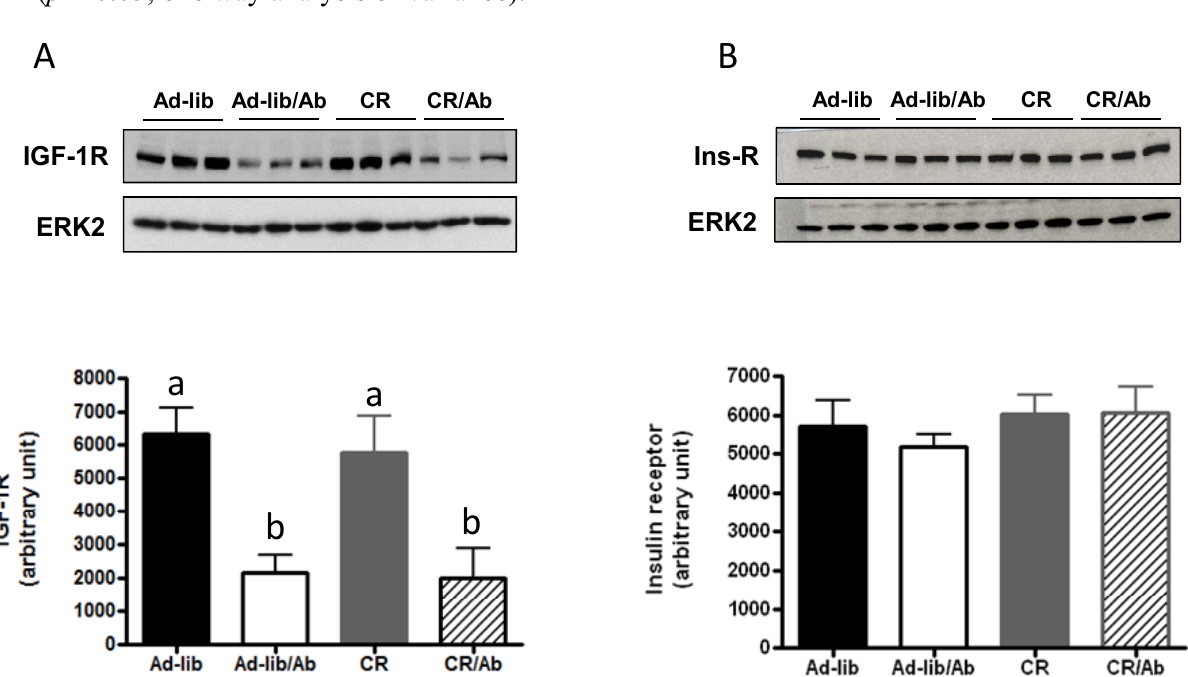
Figure 3. Effect of the intervention on IGF-1 and Insulin receptors expression in 22Rv1 xenografts. ( A ) IGF-1 receptor expression; ( B ) Insulin receptor expression. In ( A ) and ( B ), total ERK2 was used as a loading control. The Western blots are representative of one experiment ( n = 3 animals per group). The western blots were done on a total of 6 animals per group. Densitometric analysis is presented in the bar graphs for both IGF-1R and the insulin receptor. Means with different letters are significantly different from each other ( p < 0.05, one way analysis of